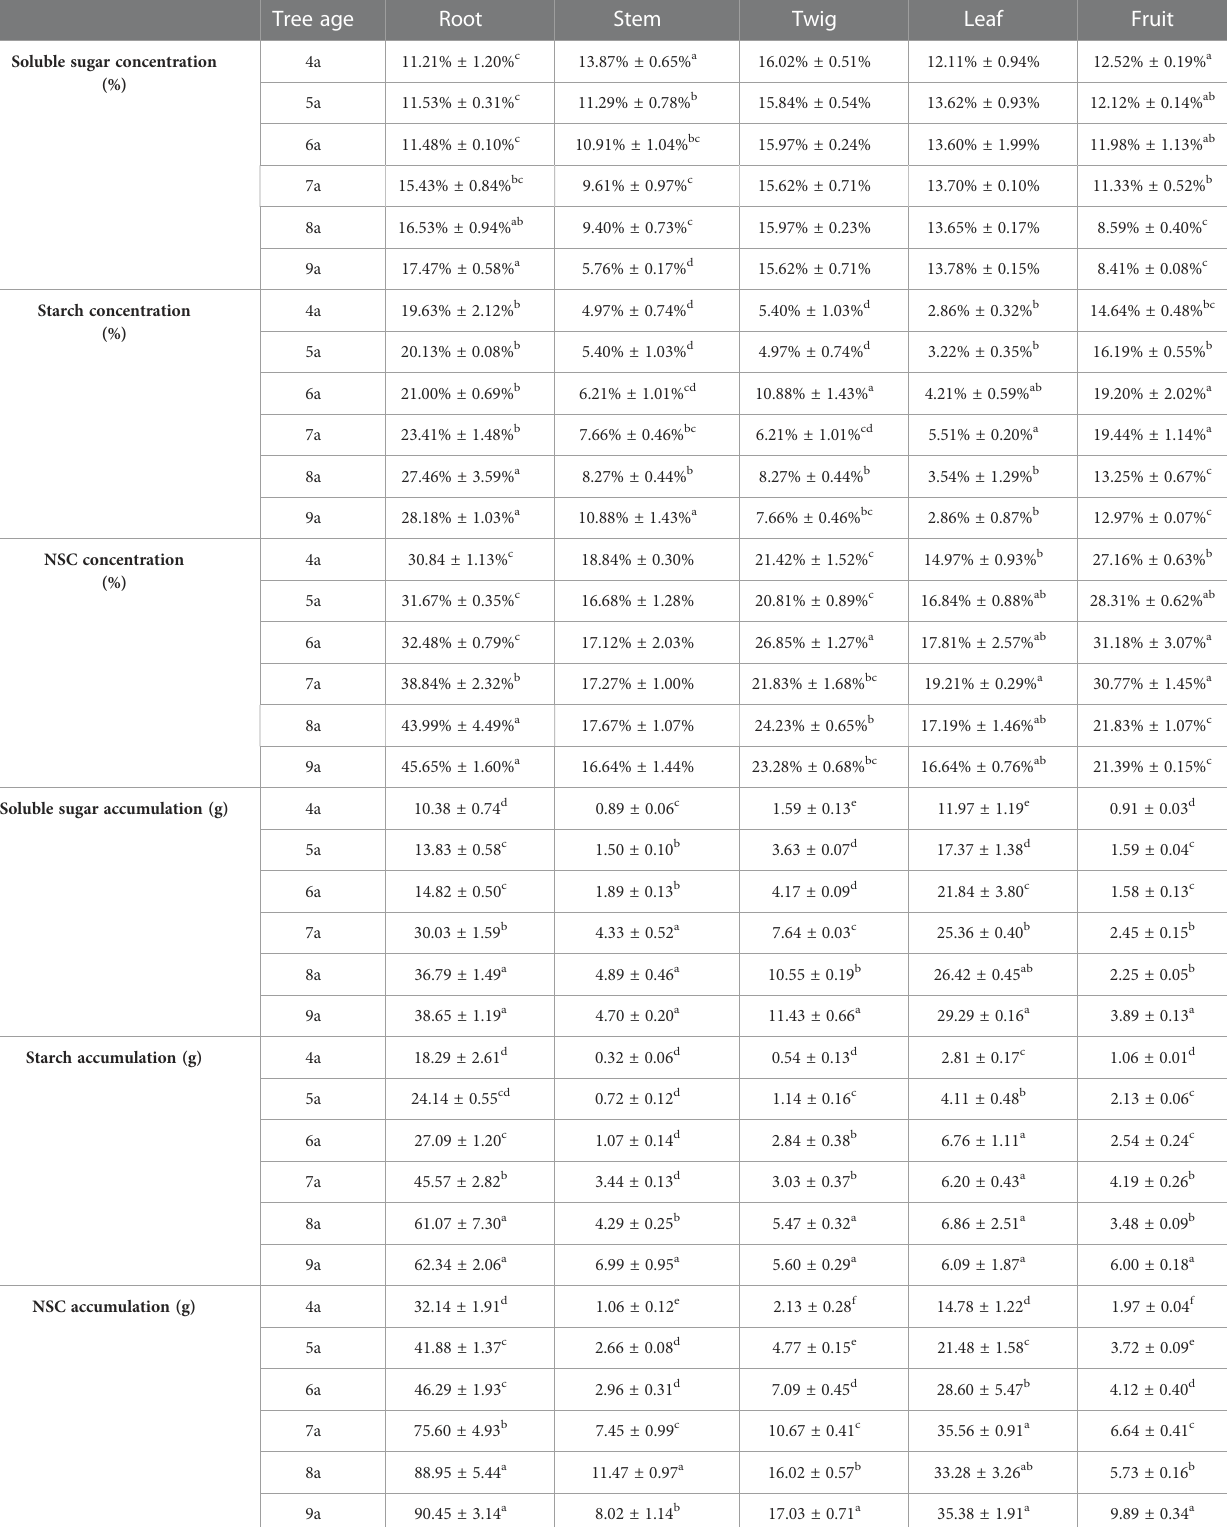
TABLE 4 Average values of the concentrations and accumulations soluble sugar, starch, and NSC of each organ and whole-plant of Fengdan during fruit ripening. Tree age Root Stem Twig Leaf Fruit Soluble sugar concentration